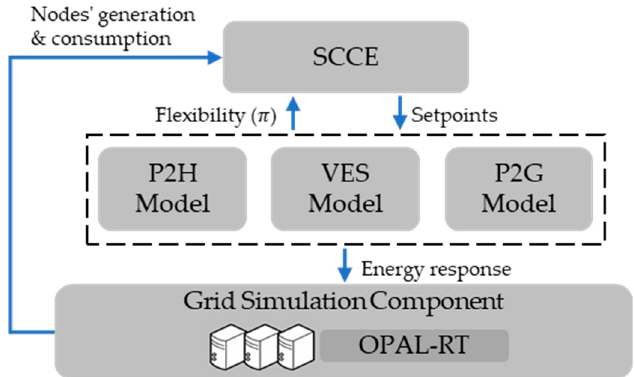
Figure 5. Flexibility information flow in the PLANET architecture.